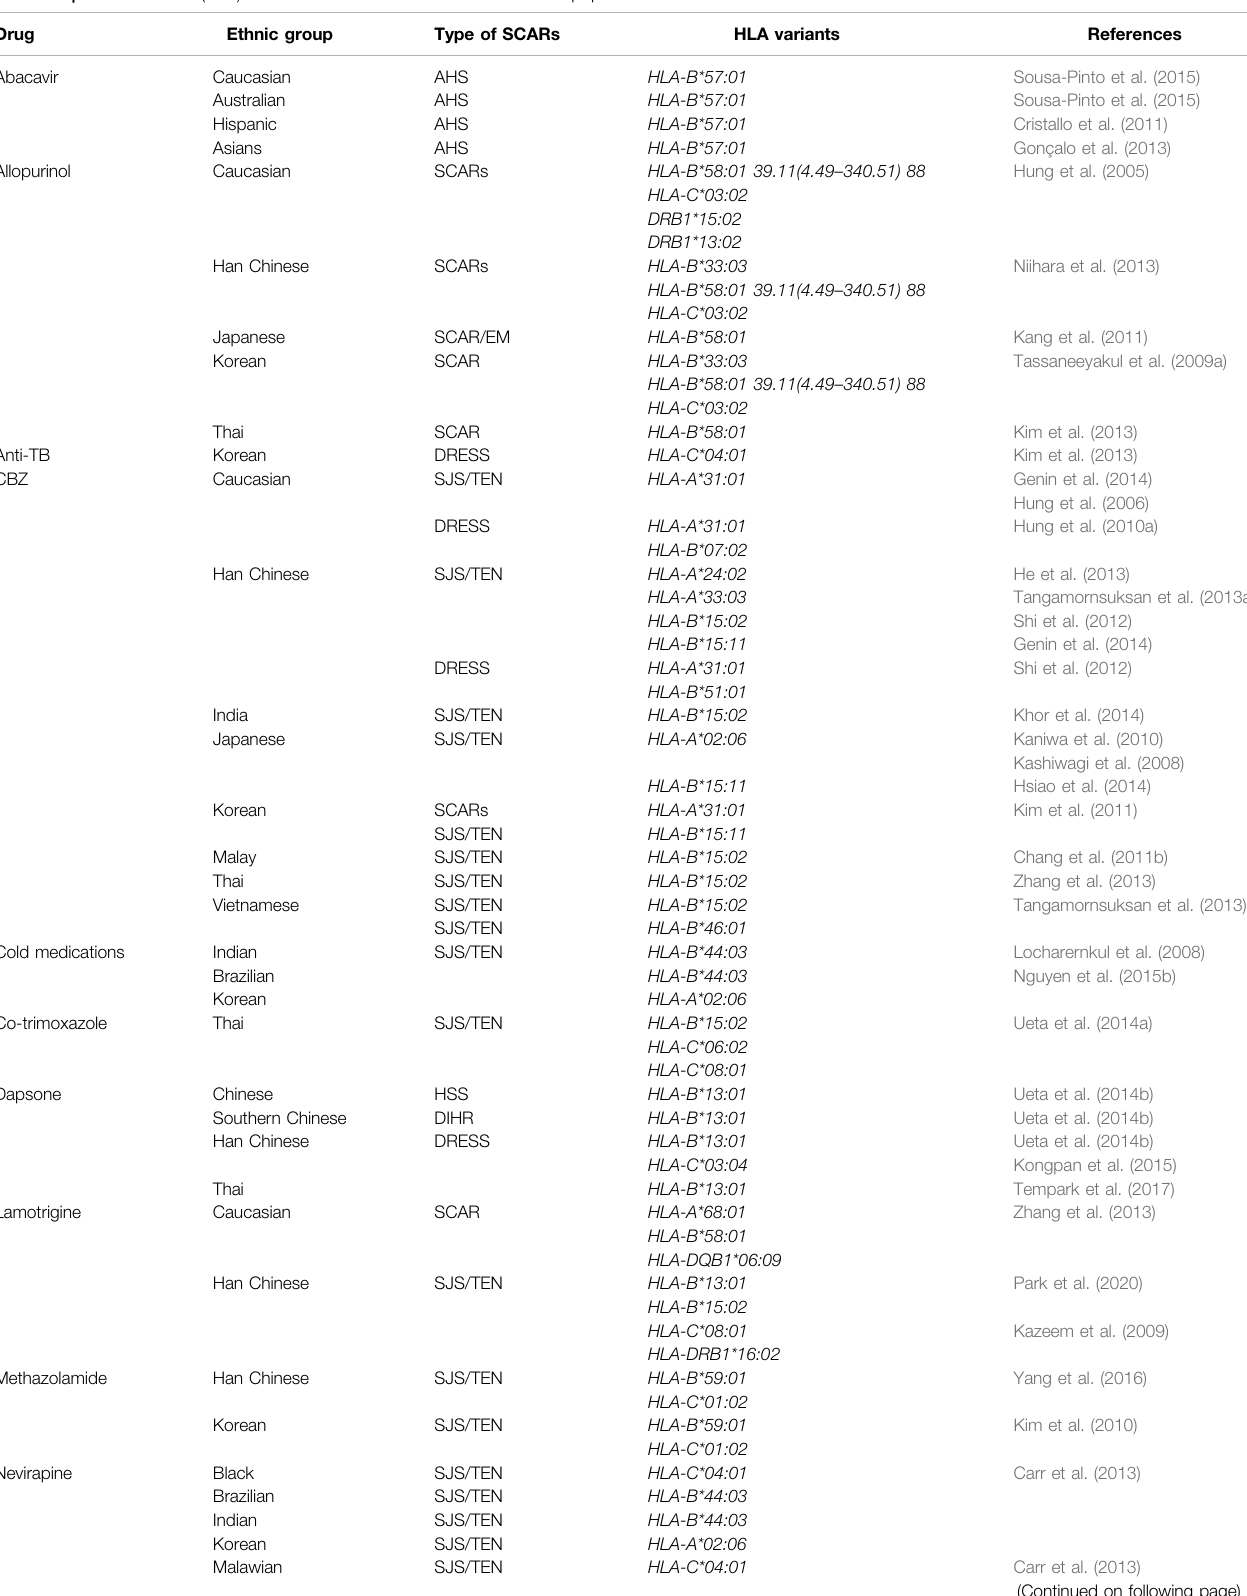
TABLE 1 | Genetic factors (HLA) associated with various SCARs in different